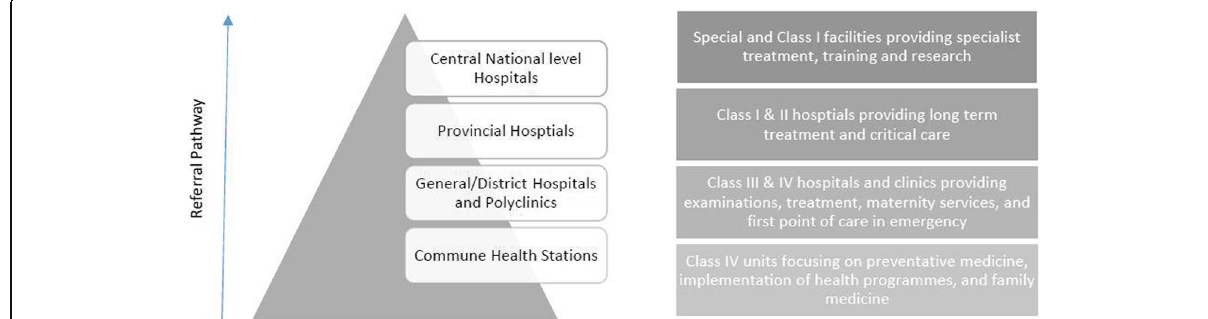
Fig. 1 Overview of the structure, class categorisation and functions of different levels of the Vietnamese health system [6]. Adapted from Shillabeer